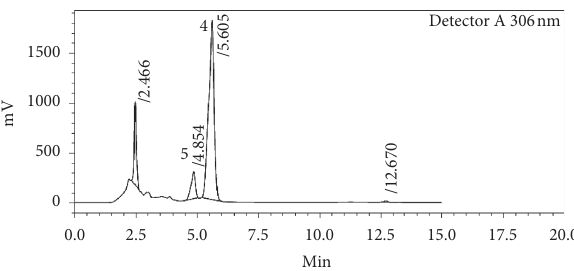
Figure 4: HPLC analysis of compounds 4 and 5 in the methanol leaf